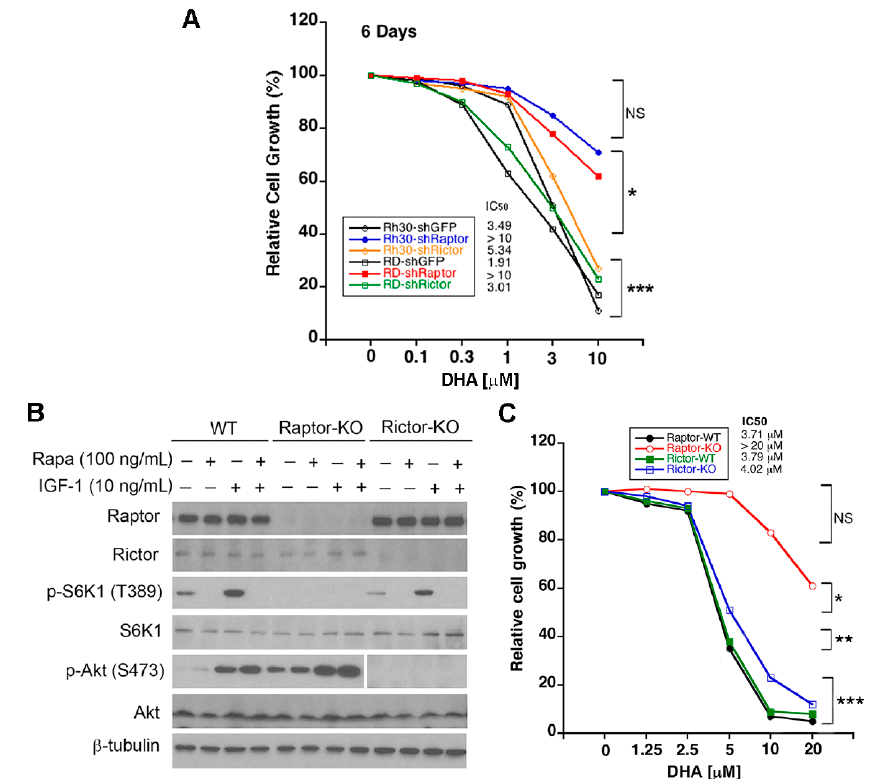
Figure 2. Disruption of mammalian target of rapamycin complex 1 (mTORC1), but not mammalian target of rapamycin complex 2 (mTORC2), confers high resistance to DHA-induced cell growth suppression. ( A ) Rh30 and RD cells, infected with lentiviral shRNAs to raptor, rictor, or GFP (control), were treated with DHA (0 − 10 µ M) for 6 days, followed by cell counting using a Beckmann Coulter counter. ( B ) Raptor or rictor-inducible knockout mouse embryonic fibroblasts (MEFs) were treated with or without 4-hydroxytamoxifen (4-OHT) (1 μ M) for 3 days, to generate raptor-WT, raptor-KO, rictor-WT, and rcitor-KO cells. Western blotting was performed with indicated antibodies. ( C ) Indicated cells, seeded in 96-well plates (all at 4 × 10 3 cells/well), were treated with DHA (0–20 µ M) for 72 h, followed by MTS assay. Shown are mean values ( n = 3). NS, not significant; * p < 0.05; ** p < 0.01; *** p < 0.001, difference versus vehicle control group ( A , C